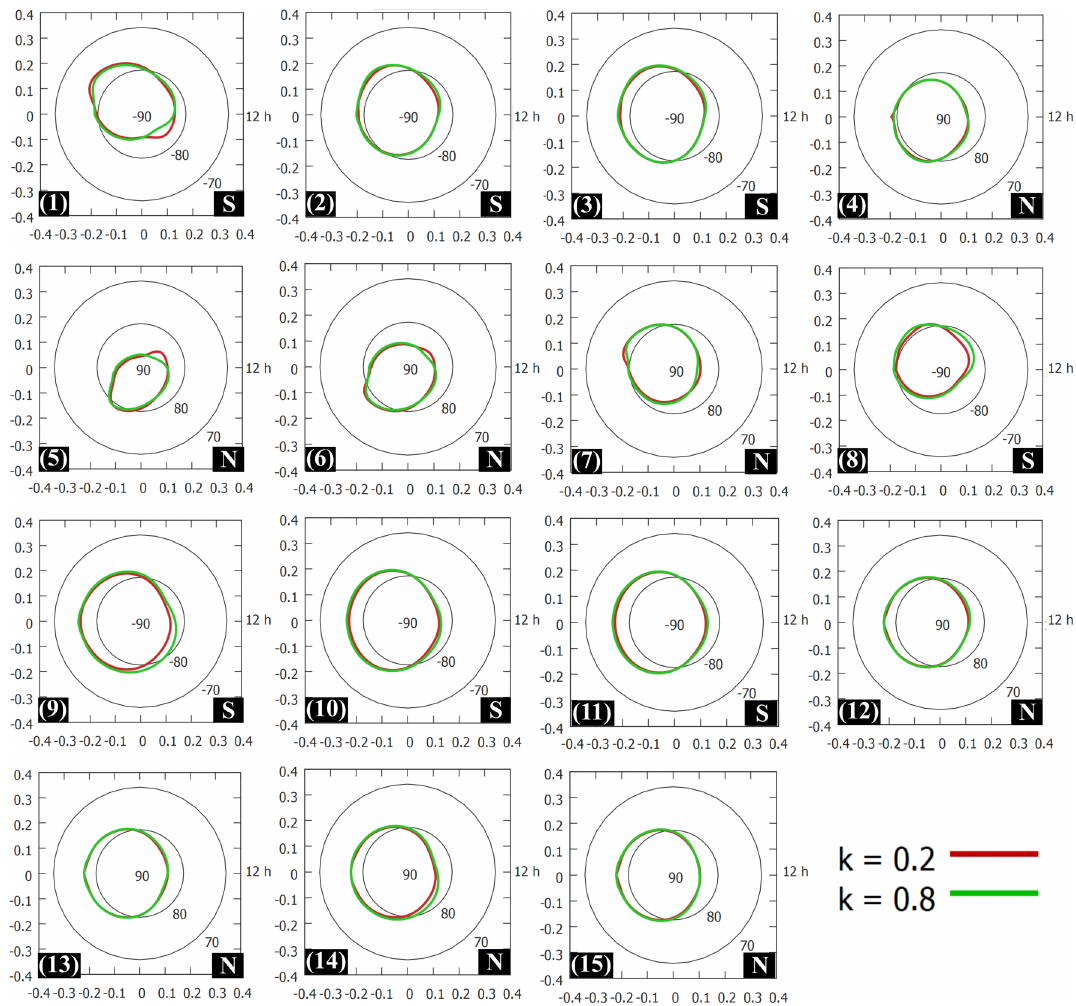
Figure 9. Ionospheric open field line area calculated for all cases from Table 1 for different values of the IMF penetration coefficient into the Kronian magnetosphere; k = 0 . 2 (red curve) and k = 0 . 8 (green